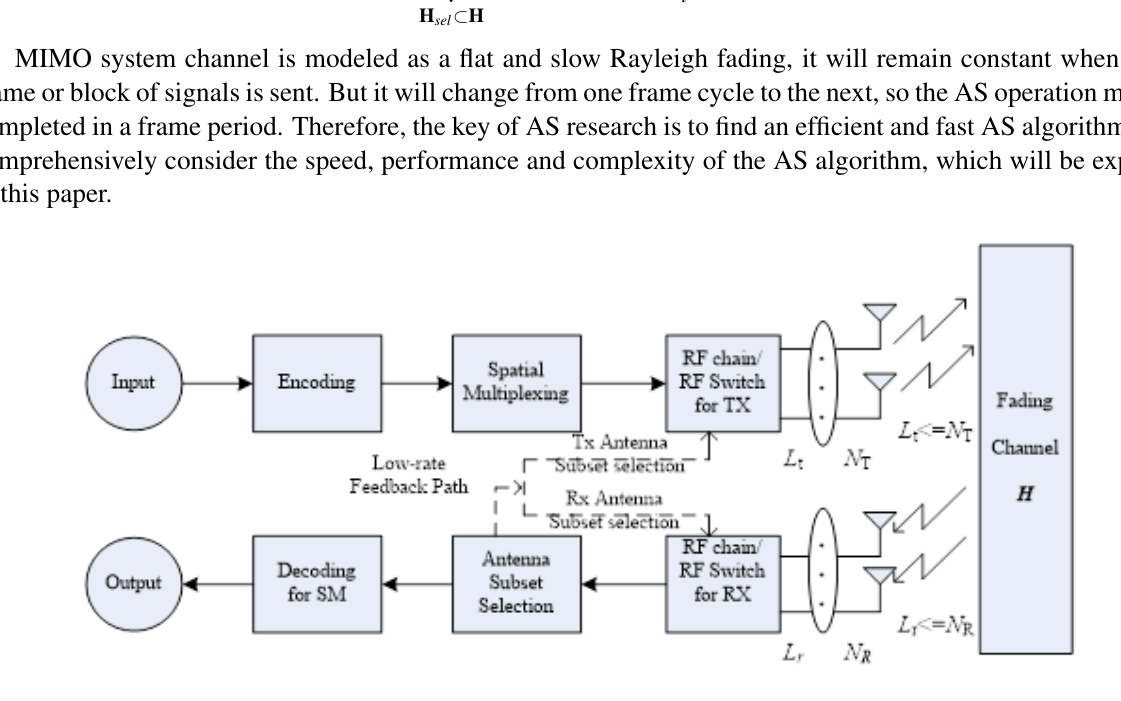
Fig. 1 Composition block diagram of an AS scheme based on spatial